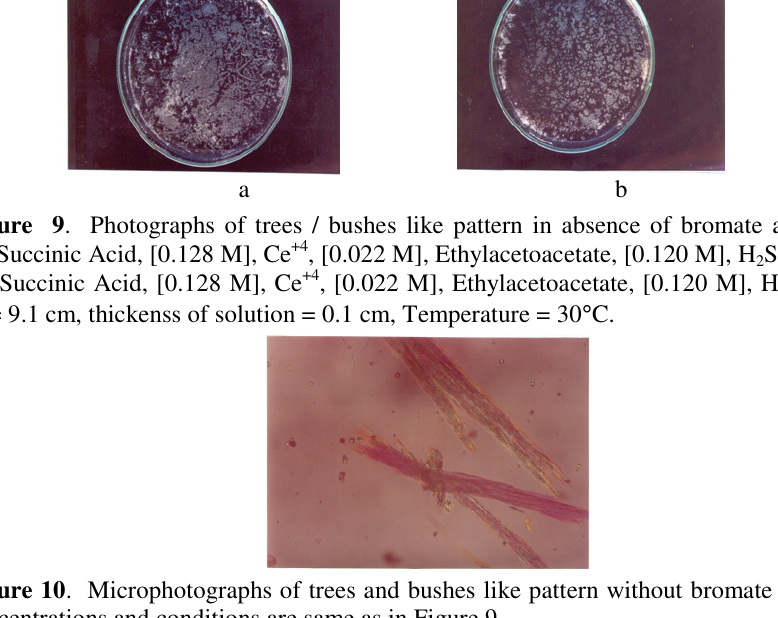
Figure 10 . Microphotographs of trees and bushes like pattern without bromate and ferroin concentrations and conditions are same as in Figure